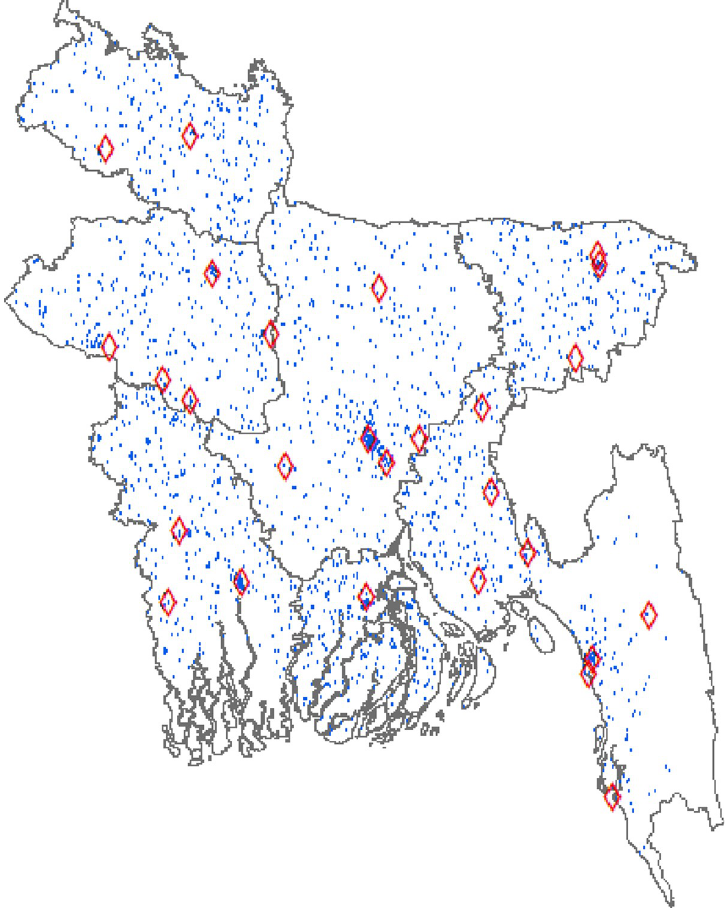
Fig 1. Geographic distribution of rainfall stations across Bangladesh. Rainfall stations are illustrated by red diamonds. Residential clusters are in blue dots. The figure is created using ArcMap. The data used to construct the map were obtained from the following open access sources: Data for rainfall stations are from the Global Historical Climatology Network monthly and downloadable from https://ncei.noaa.gov/products/land-based-station/global- historical-climatology-network-monthly. Data for residential clusters are from the Bangladesh Demographic and Health Survey and downloadable from https://dhsprogram.com/data/available-datasets.cfm. The base map layer is from the Database of Global Administrative Areas and downloadable from https://gadm.org/download_country.html.